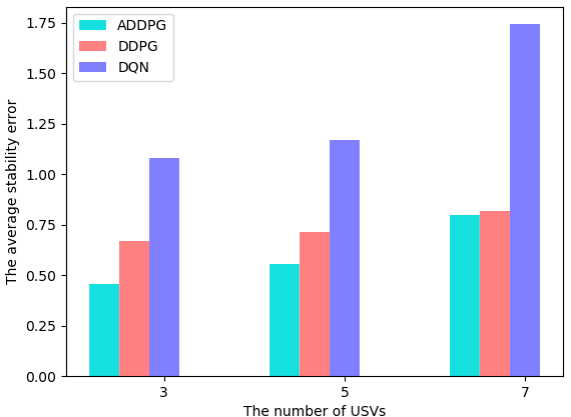
Figure 9. The average stability difference with the different number of multiple cooperative USVs and different schemes.